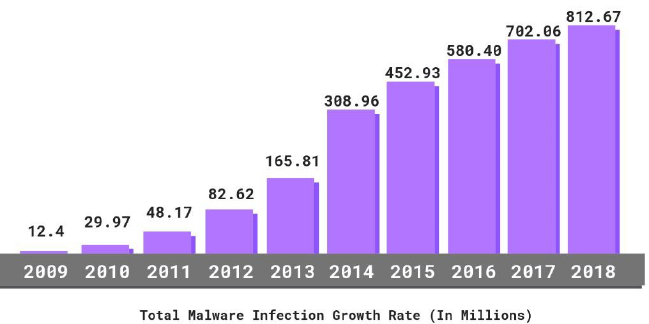
Figure 1. Total malware inflection growth rate [1]: many computers are affected daily by malware, and an increasing number of intrusion detection systems (IDS) target network malicious activity.